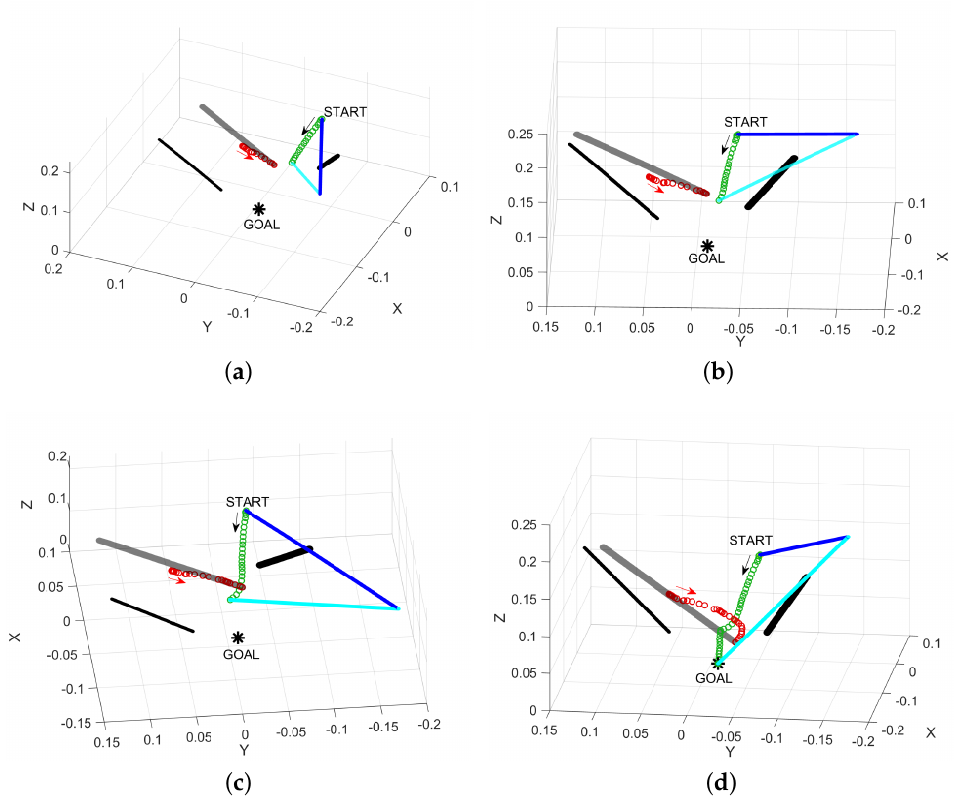
Figure 14. In blue, the starting pose of the robot, while in light-blue, the pose in the related snapshot. In black, the other laparoscopic tools, which are to be considered as obstacles (in transparent black, the moving one). In green, the trajectory of the EE. In red, the trajectory of the moving obstacle. ( a ) First snapshot; ( b ) second snapshot; ( c ) third snapshot; ( d ) final